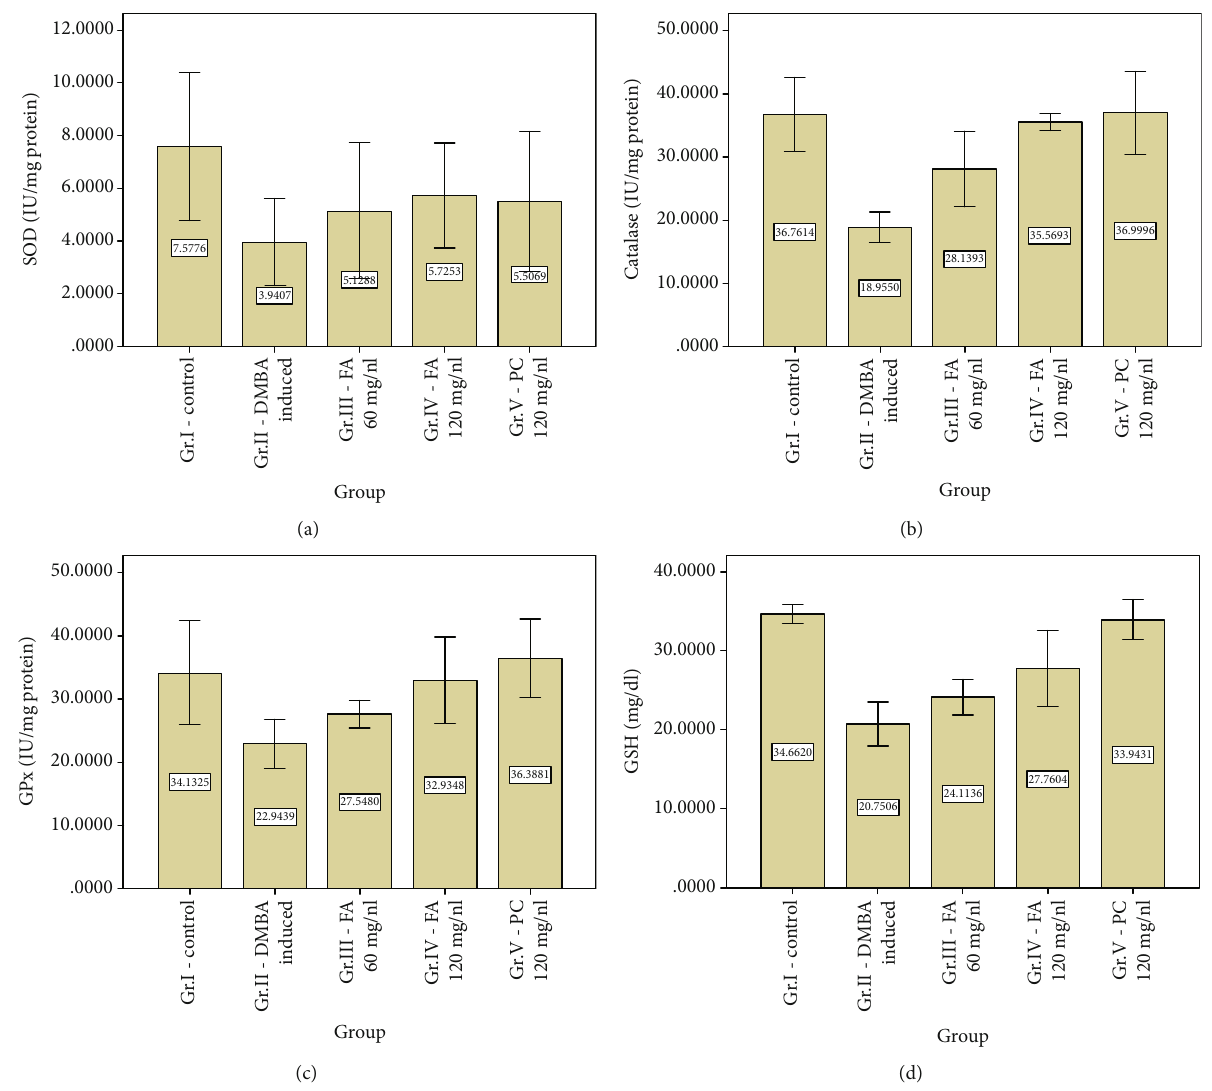
Figure 9: (a – d) In vivo antioxidant enzymes in skin tissues of experimental mice (The DMBA signi fi cantly ( p < 0 : 05 ) decreased levels of SOD, CAT, GPx, and GSH, whereas, the FA enhanced the antioxidant enzymes activity of SOD, GSH, GPx, and